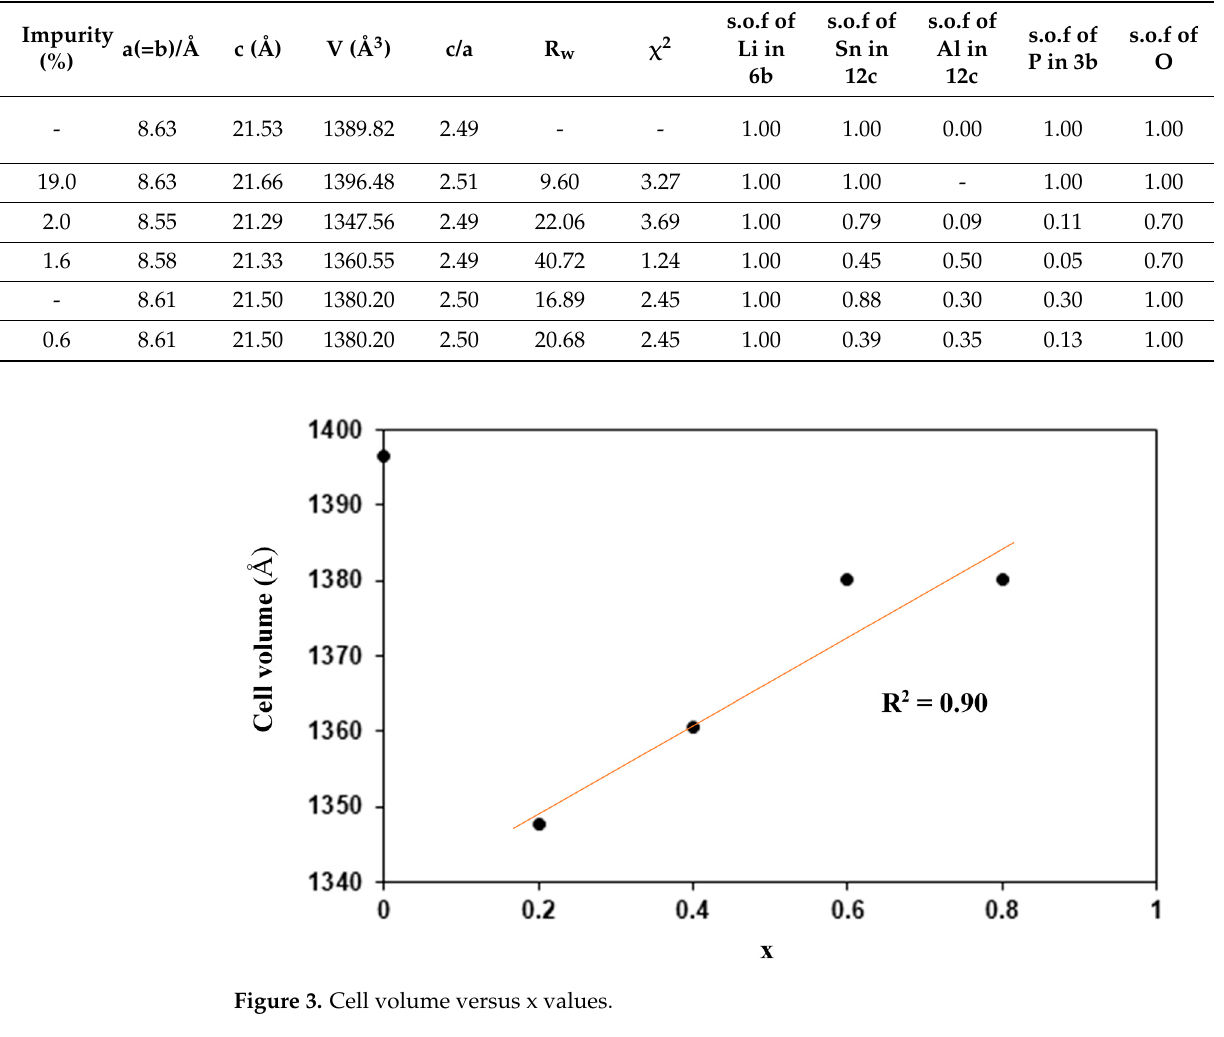
Table 1. Lattice parameters and side occupancy factor (s.o.f.) of Li 1+x Al x Ti x Sn 2 − x P 3 O 12 (x = 0.2, 0.4, 0.6, 0.8) sintered at 950 ◦ C.